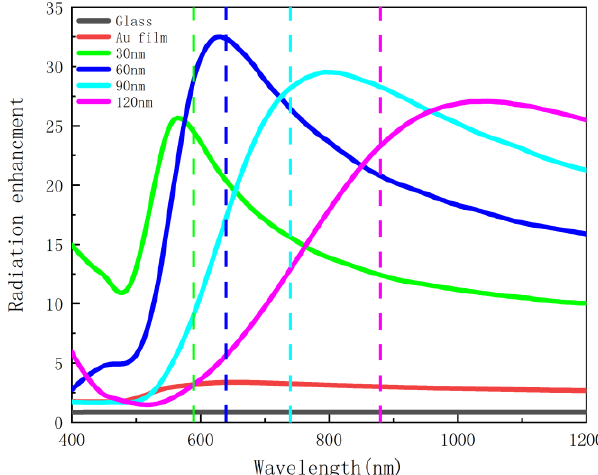
Figure 7. Radiation enhancement as a function of wavelength with different hemisphere radii (the dashed lines represent the peak wavelengths of the scattering cross-section).